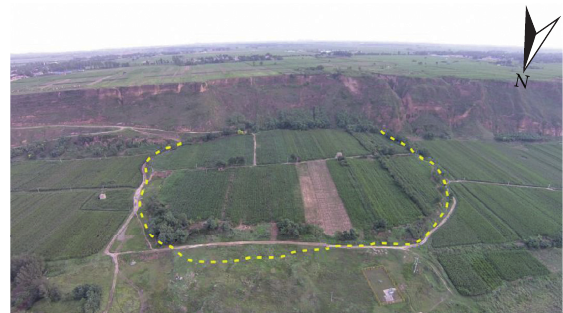
Figure 7: Xi Hetan flowslide, in China (34 ° 29 ′ 32 ″ N 108 ° 50 ′ 13 ″ E).